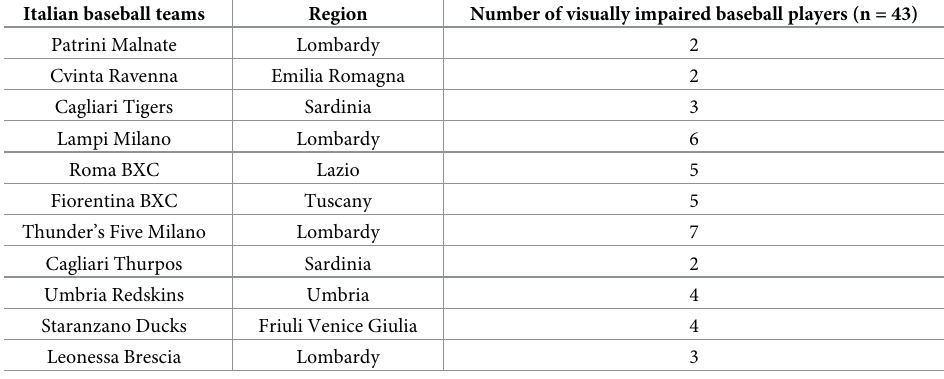
Table 1. List of Italian baseball teams composed of visually impaired athletes who responded to the